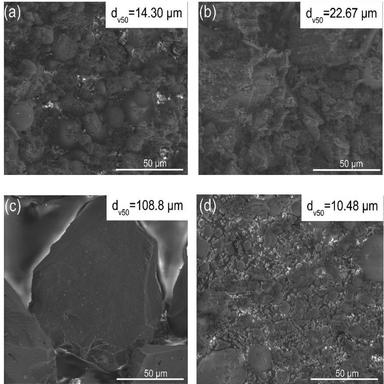
The morphology and particle size distribution of the raw materials: (a) fly ash, (b) magnesite, (c) quartz and (d) S-3.